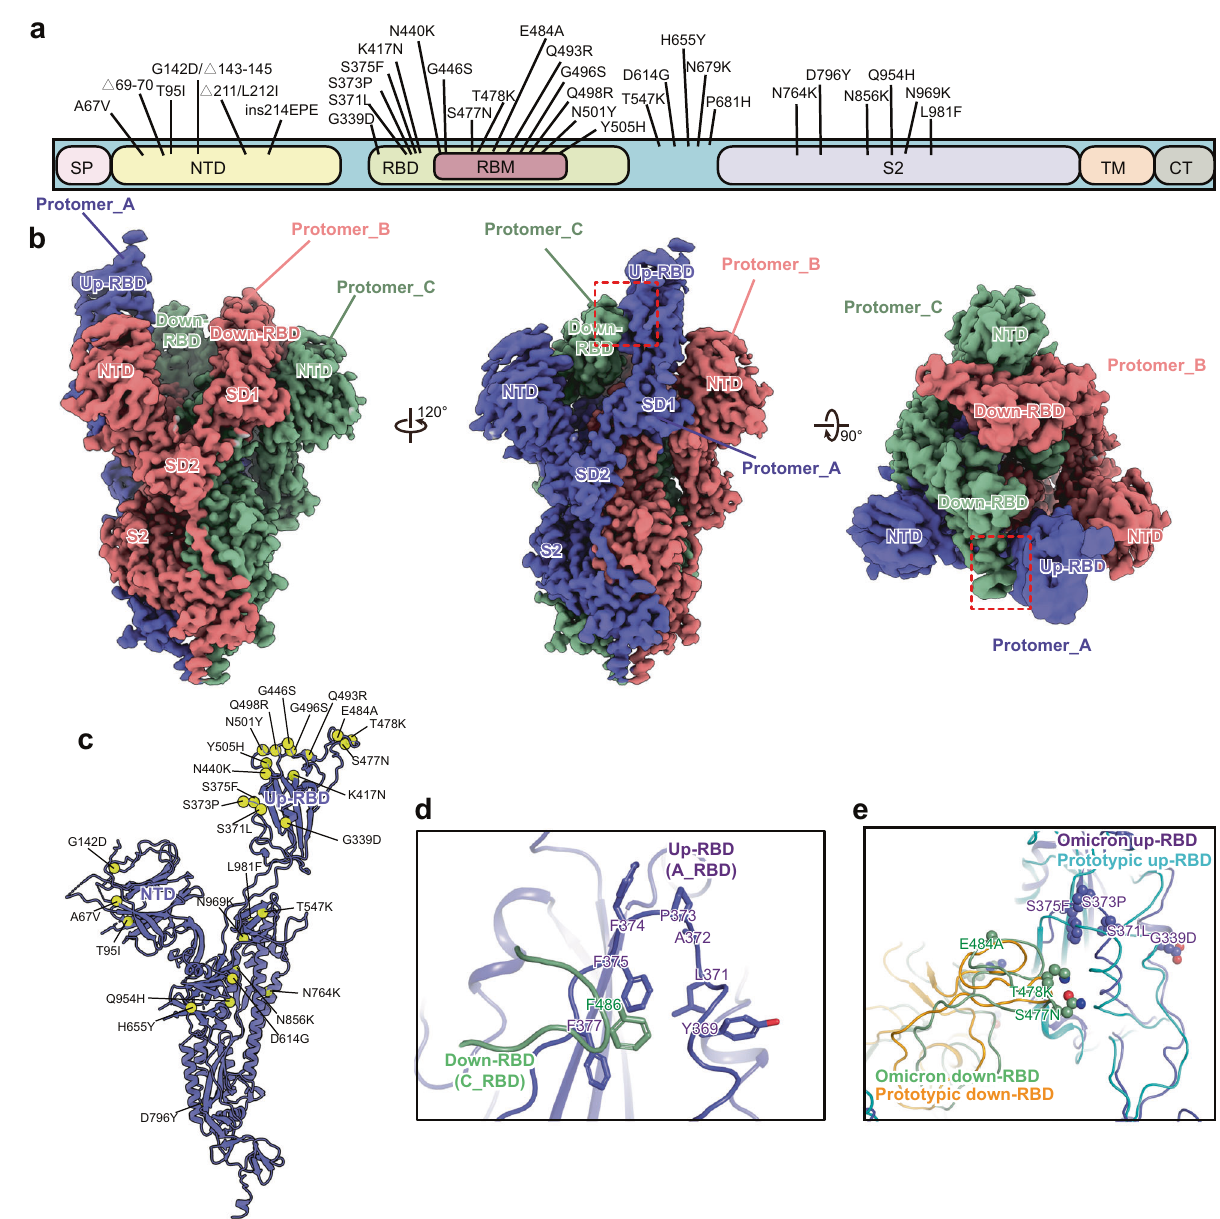
Fig. 1 | Cryo-EM structure of the Omicron spike ectodomain trimer. a A sche- matic diagram showing the amino acid mutations of the spike protein. b Cryo-EM map of the Omicron spike protein. Three protomers are colored in medium slate blue, light coral and dark sea green, respectively. The contact interface between down-and up-RBDs is boxed by the red dash line c Atomic structure of the